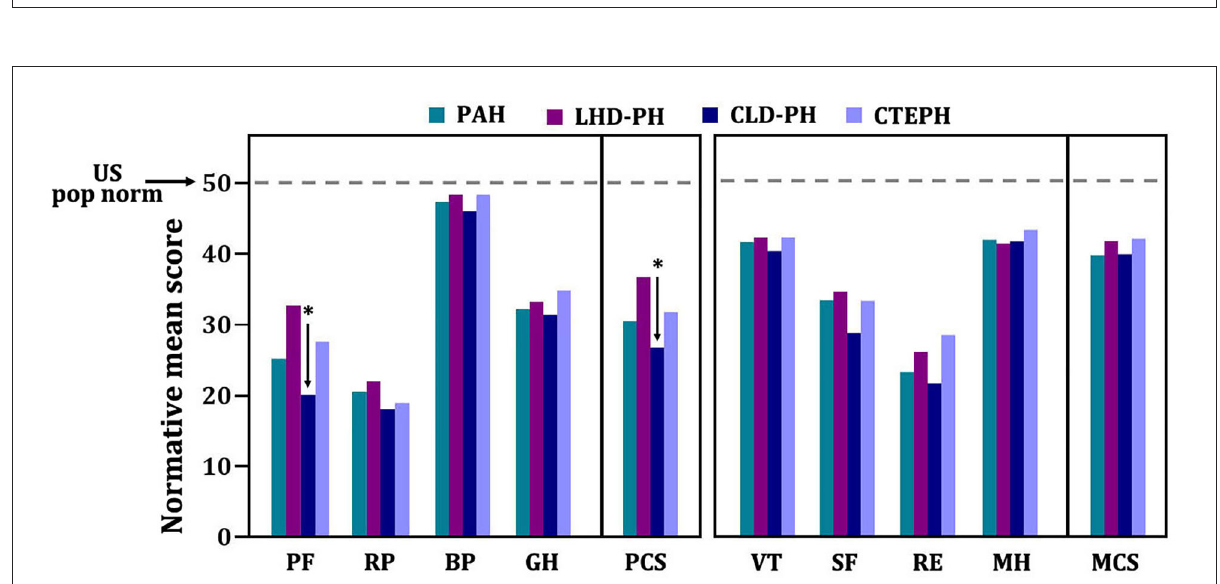
FIGURE3 SF-36 scores of patients with pulmonary hypertension in different diagnosis types. Normative mean scores based on U.S. norm population are shown. Numerically higher scores represent better health-related quality of life. *A p < 0.05 indicates comparison among different diagnosis types in each domain or summary score. BP, body pain; GH, general health; MH, mental health; PF, physical functioning; RE, role emotion; RP, role physical; SF, social functioning; VT,